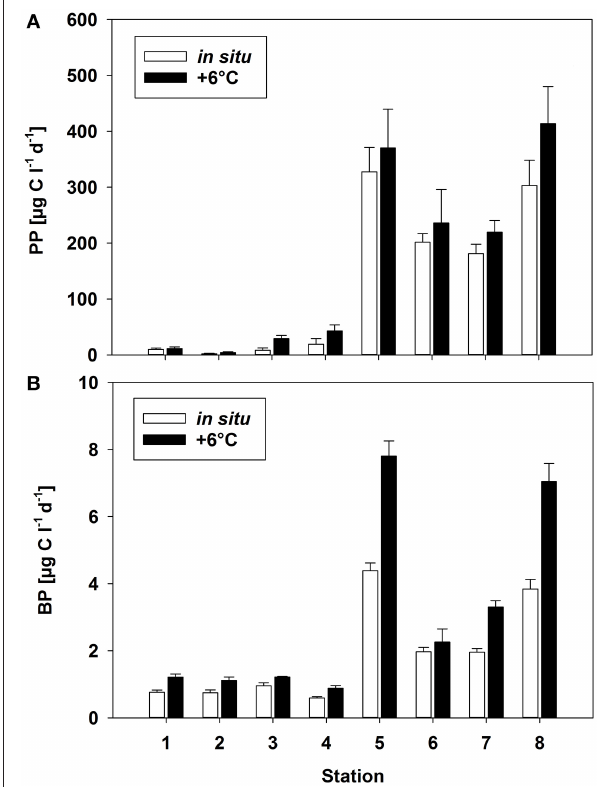
FIGURE 3 | (A) Primary production (PP) and (B) bacterial production (BP) rates [ µ g C L − 1 days − 1 ] at two different temperatures ( 1 0 ◦ C and 1 + 6 ◦ C) at the different stations. Mean ( ± SD) of three replicate